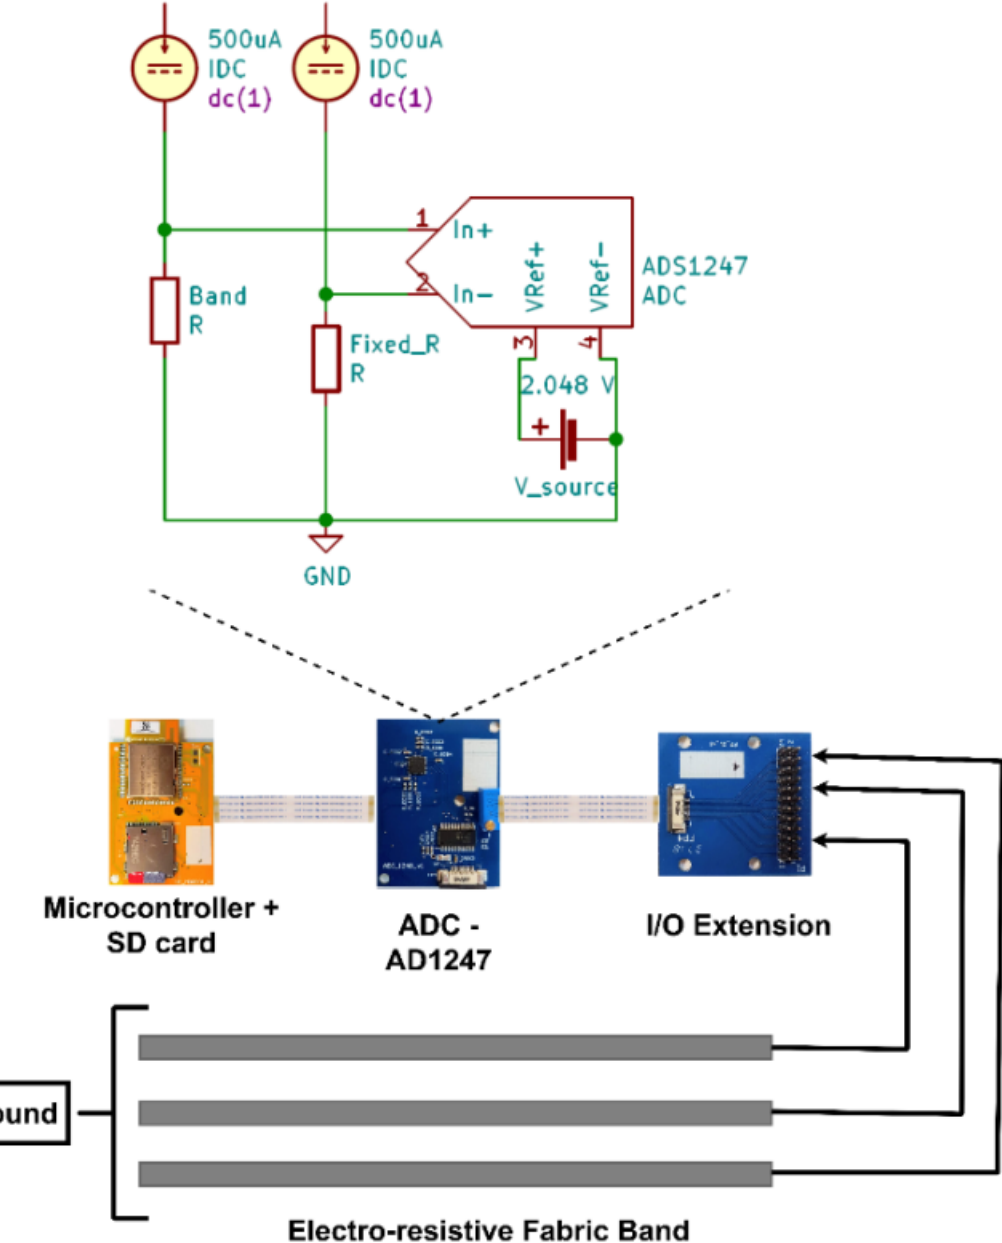
Figure 5. The analog to digital converter front-end used to measure the band resistance and the complete hardware configuration of data collection and data storage